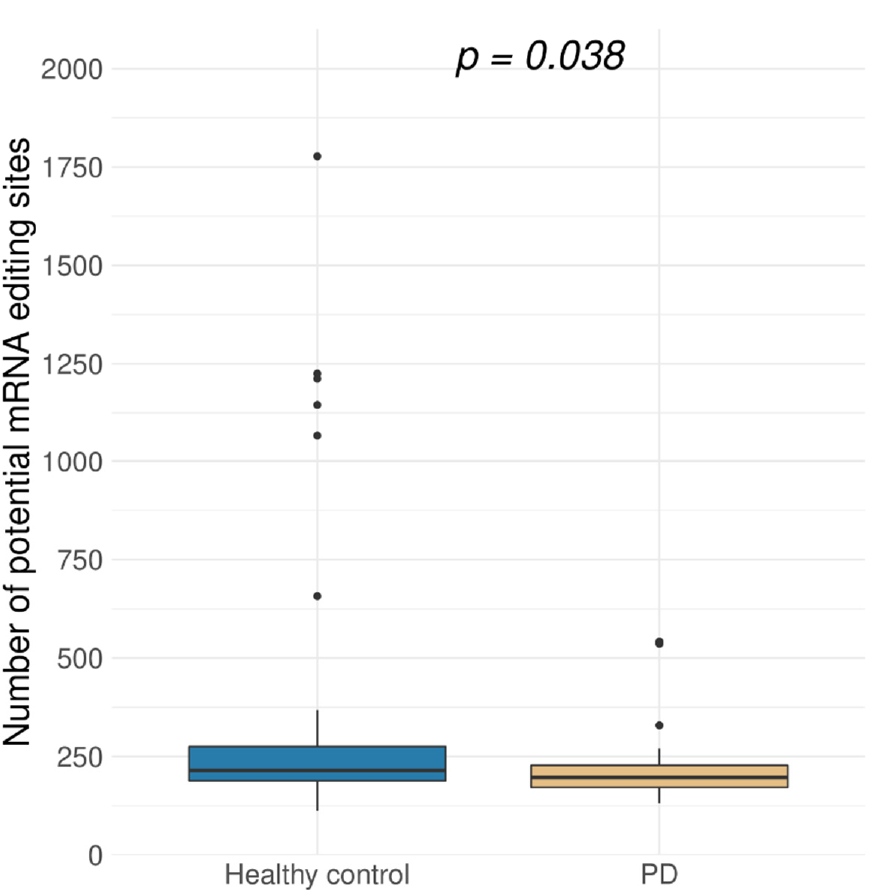
Figure 2. Distribution of the number of potentially edited A-to-I sites in exonic regions of protein-coding genes in brain samples for Parkinson’s disease (PD, 29 samples) and healthy control (44 samples) ( p = 0.038, Wilcoxon test). Potentially edited sites were predicted using REDItools software [20]. Table 2. Differential expression analysis of RNA-specific adenosine deaminases in PD patients’ brains versus the healthy